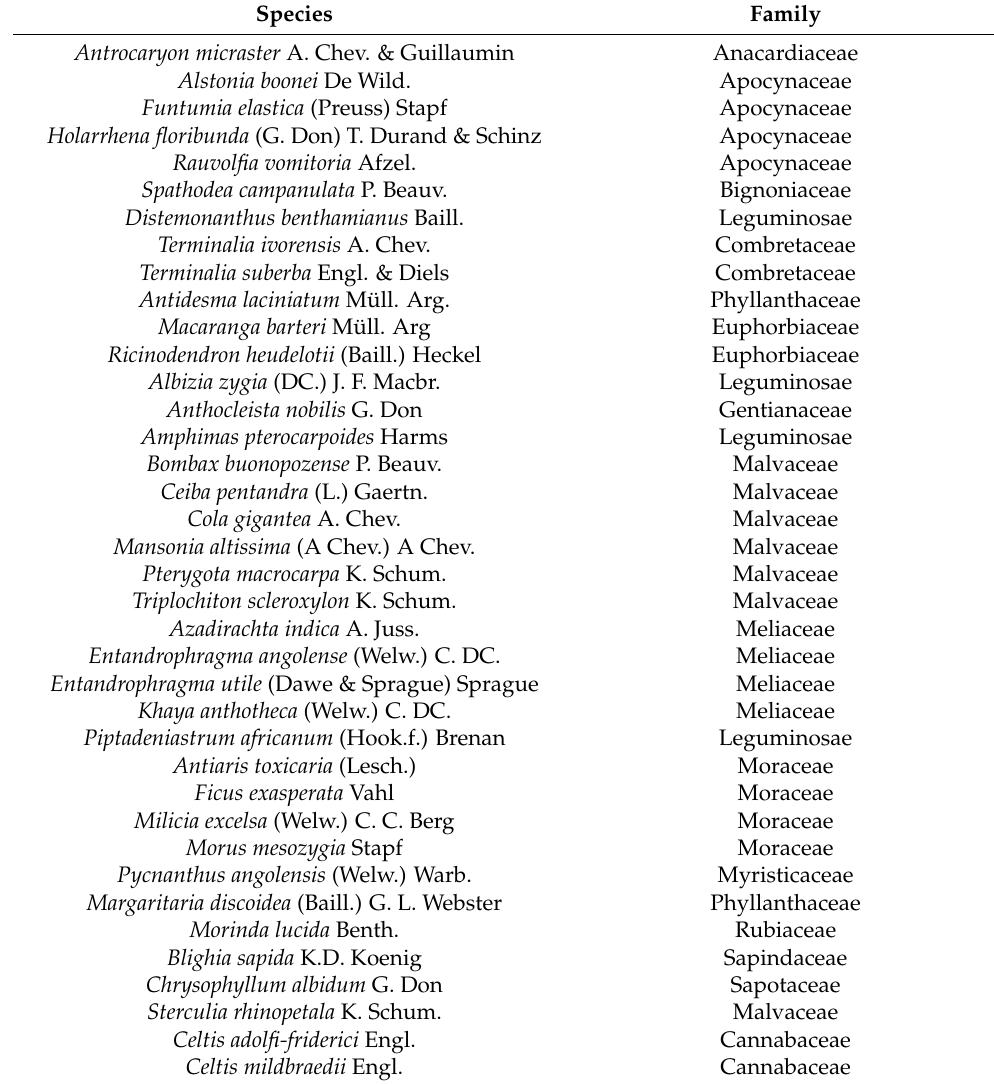
Table A1. Tree species considered for trait measurement. Family names of species adopted from The Plant List